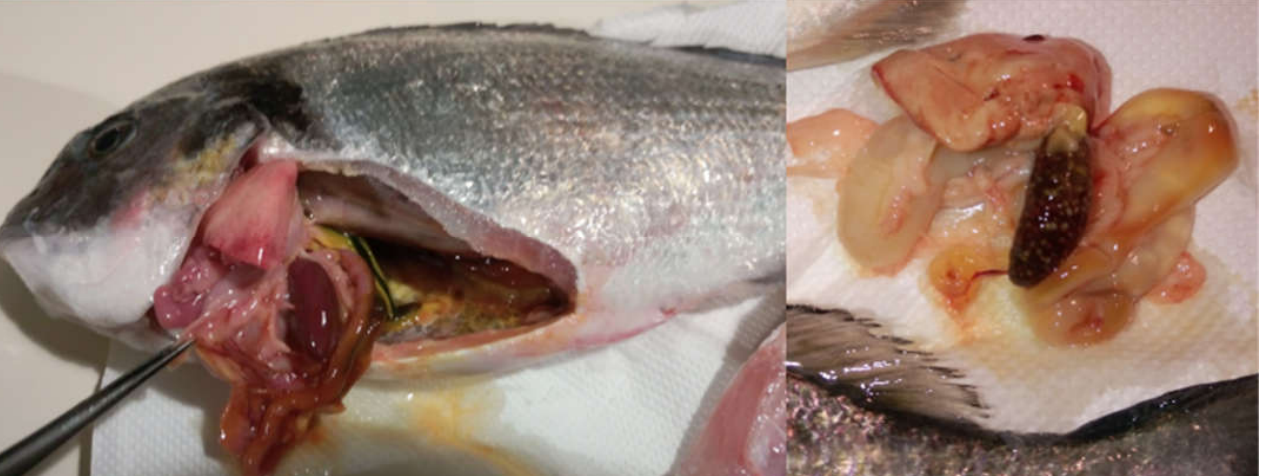
Figure 3. Splenomegaly in red porgy ( Pagrus pagrus ) ( left ) and sea bass ( Dicentrarchus labrax ) ( right ). All but one strain isolated in TSA agar were identified as Photobacterium damselae sbsp. piscicida (Table 1) using both applied techniques. Maximum likelihood phylogenetic analysis of the 16S rRNA segment demonstrated only two haplotypes identical with al- ready available P. damselae sbsp. piscicida and P. damselae sbsp. damselae haplotypes in the GenBank database (Figure 4, Supplementary file 1). These results confirmed the molecular identification of the cultured bacteria as P. damselae sbsp. piscicida and P. damselae sbsp. damselae (Table 1).